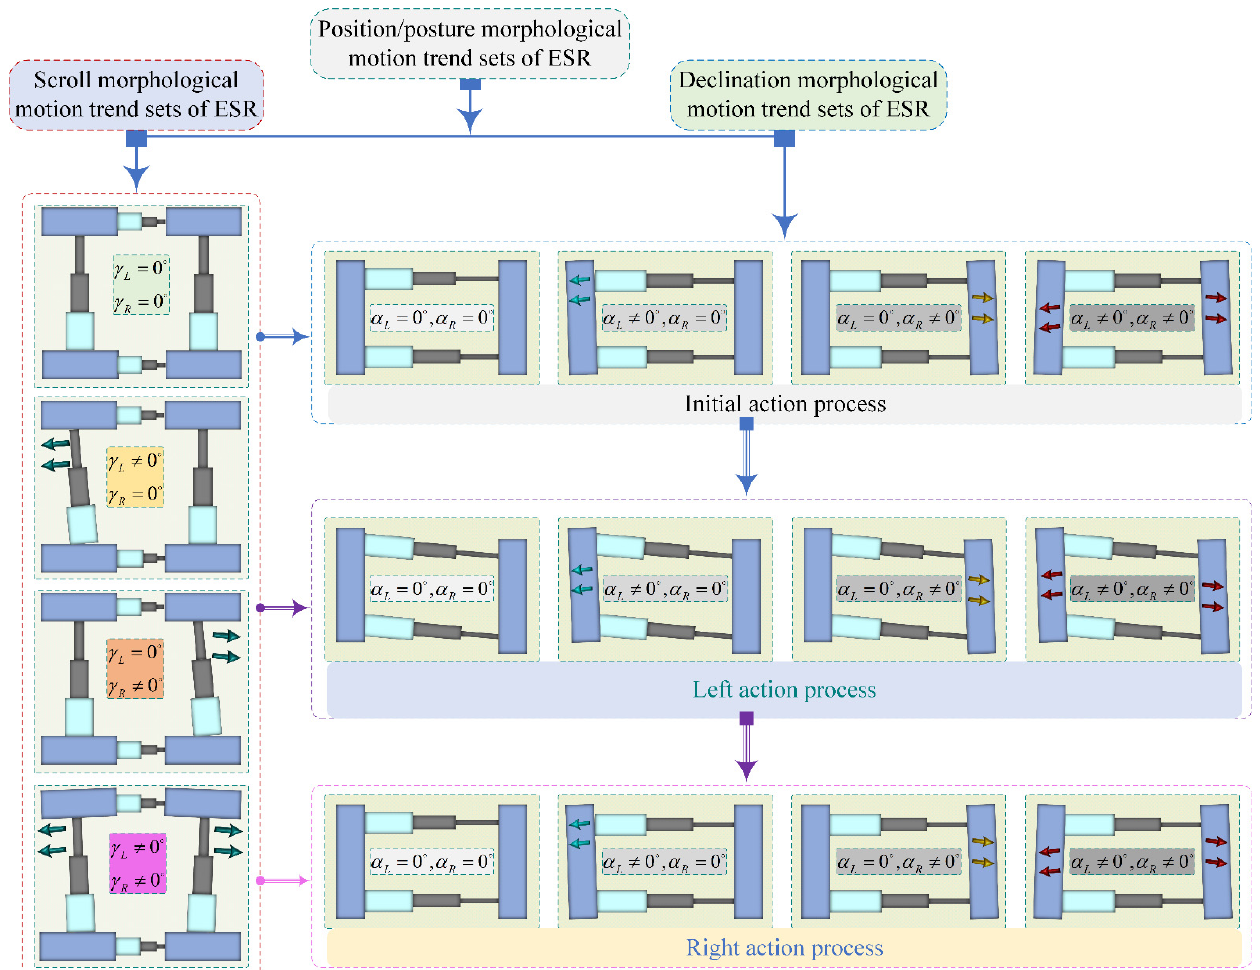
Figure 9. The position/posture morphological motion trend sets of ESR.